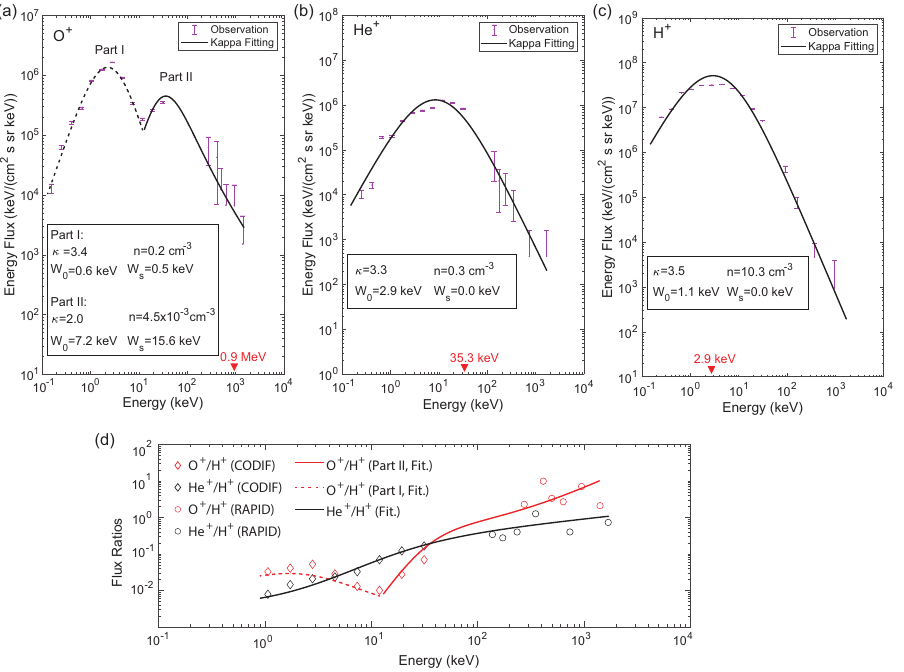
Figure 4. ( a – c ) The energy flux spectra of O + , He + and H + around the minimum B t in Cusp 1, respectively. The largest magnetic depression occurred at about 23:02:54 UT. The pink dots with error bars are the averaged energy fluxes between 23:02:40 UT and 23:03:10 UT. The black lines represent the best fit of the energy fluxes with the kappa distribution, and the fitting parameters are marked in the legend. The red arrows represent the maximum energy increase in Cusp 1 caused by electric fields in Figure 3. ( d ) The flux ratios of O + /H + and He + /H + . The marks and lines represent the measurements and fitting results in panels ( a – c ), respectively. Since the central energies of each channel for O + , He + and H + from the CODIF and RAPID instrument are different, H + fluxes are first interpolated and then used to calculate the flux ratios. It should be noted that we adopt the background values of H + in the energy channels of 962 keV and 1885 keV, and He + in the energy channels of 737 keV and 1689 keV, which are the averages from 23:00 to 23:05 UT, because most of the measurements from 23:02:40–23:03:10 UT are absent. Considering that the first O + peak (Part I) is actually contamination due to the intense H + , the fitting result is marked by a dashed line in panels ( a , d